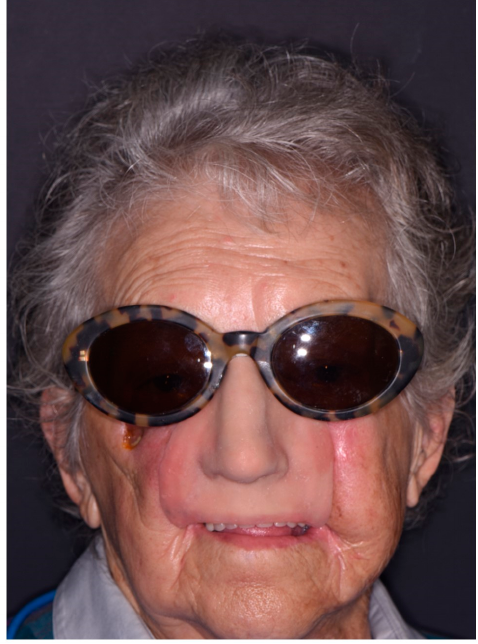
Figure 10. Final Figure 10. Final result.